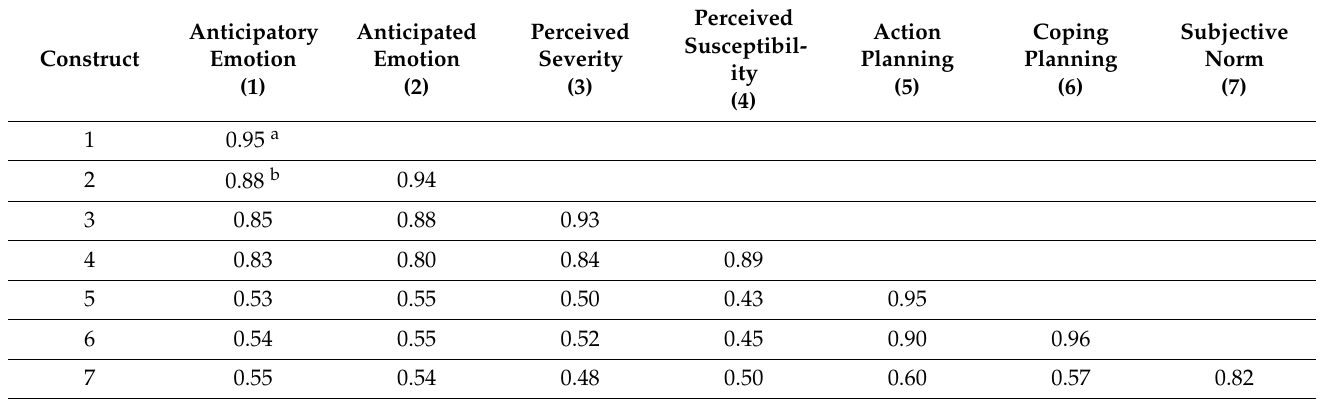
Table 4. Average variance extracted and construct